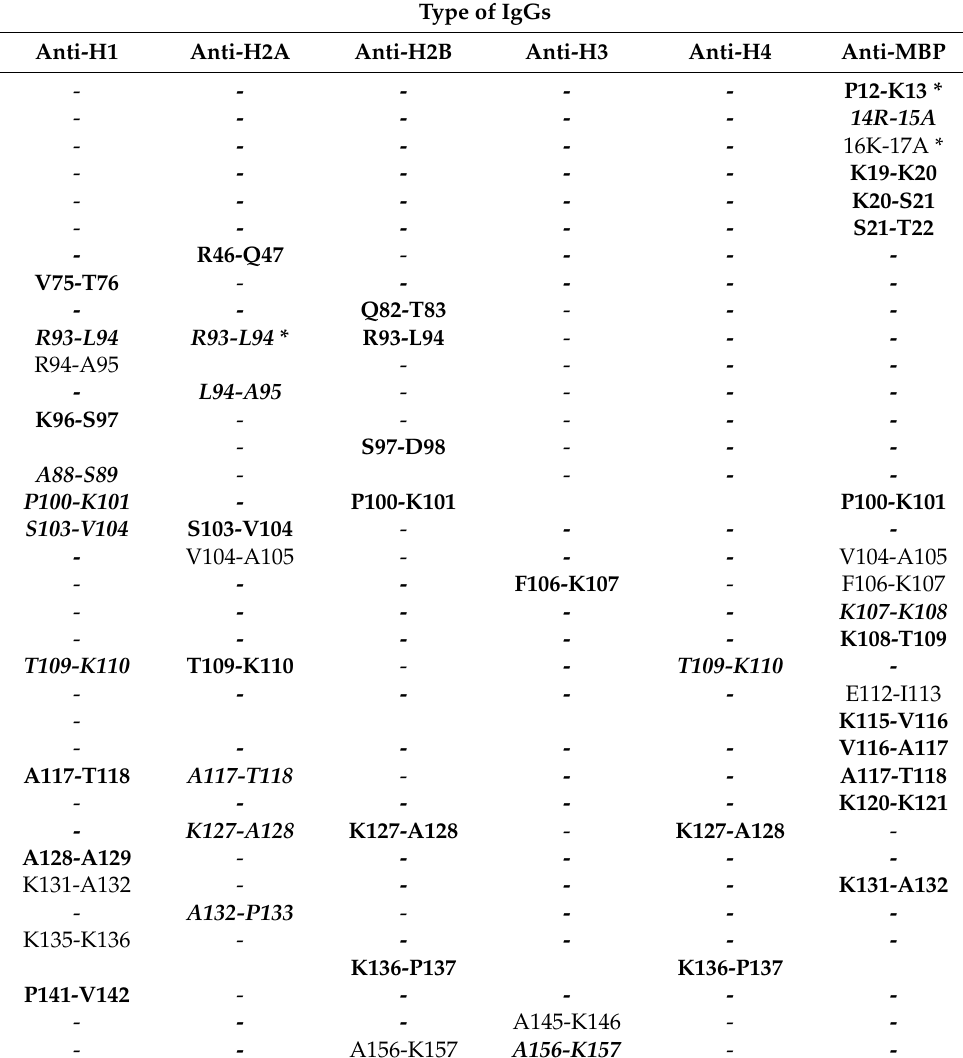
antibodies against H3 and H4 hydrolyze H1 histone very weakly. At the same time, in the zone of the first cluster from P12 to T22, the sites of H1 hydrolysis by these antibodies are completely absent. For antibodies against histones H3 and H4, only three H1 hydrolysis sites were reliably detected. Moreover, these sites are different, and they do not coincide with the sites of hydrolysis by antibodies against four other histones and against MBP, except for the site K127-A128, which is common for antibodies against H4, H2A, and H2B (Table 1). Table 1. Sites of H1 histone hydrolysis by IgGs against hive histones and